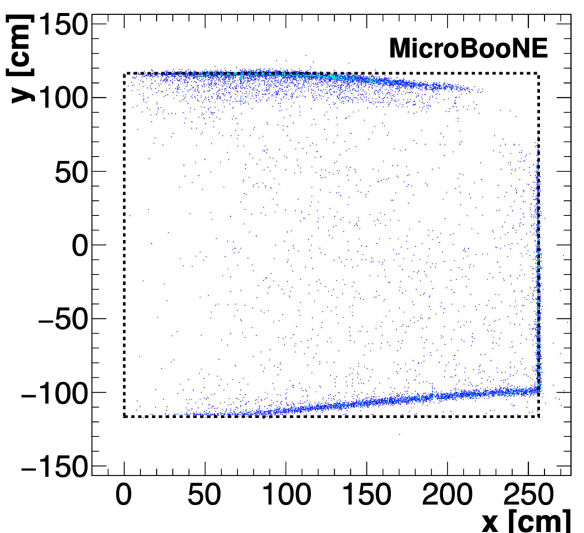
Figure 5. Entry/exit points of reconstructed cosmic muon tracks in the MicroBooNe detector, projected on the xy plane. The anode is located at x = 0 cm and the cathode at x = 256 cm. The data points accumulate on the cathode plane and on the profile of the top and bottom side faces, which appear distorted towards the center of the detector because of a transverse component in the electric field due to space-charge. Reproduced from reference